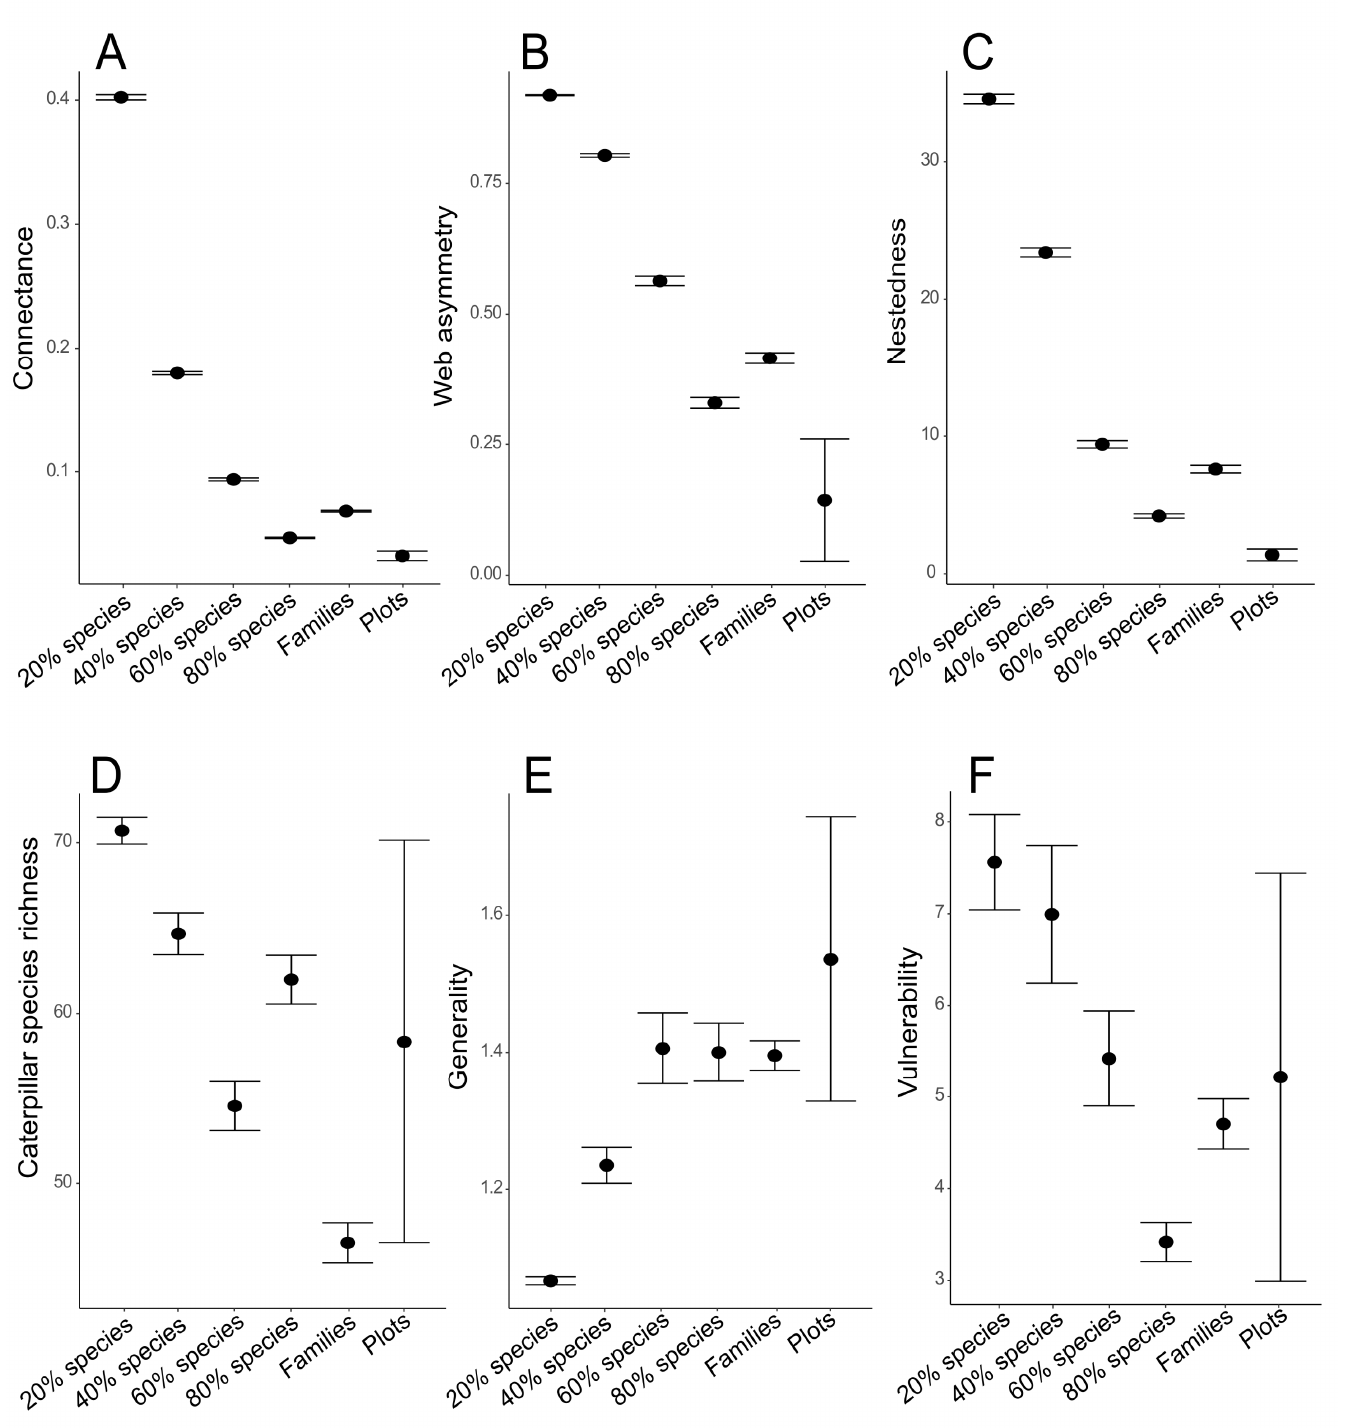
Fig 3. Parameters of plant-caterpillar interaction networks based on the plot-based data (Plots) and simulated non-plot-based data where individual tree species were sampled with equal effort. The simulated data represent a non-plot-based approach focusing on locally abundant tree species representing a certain amount of the foliage in the forest (20, 40, 60, or 80% species) or a representative selection of tree families (Families). The results are based on Yawan primary forest dataset from Redmond et al. [23]. The compared network parameters include connectance (A), web asymmetry (B), nestedness (C), species richness of caterpillars (D), weighted generality (E), and weighted vulnerability (F). All simulated datasets were rarefied to the average leaf area of a 0.1 ha plot. All rarefactions were repeated 100-times. Points show mean. Bars show 95% confidence intervals. https://doi.org/10.1371/journal.pone.0222119.g003 PLOS ONE | https://doi.org/10.1371/journal.pone.0222119 October 23,